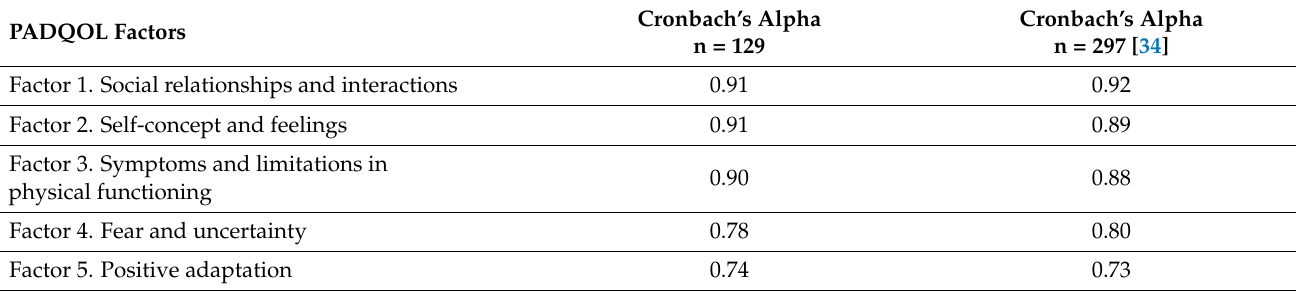
Table 5. The PADQoL internal consistency of the pre-test and final Hungarian versions compared to the original